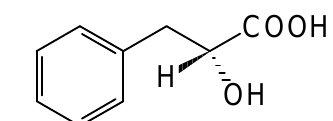
Figure 1. D -3-phenyllactic